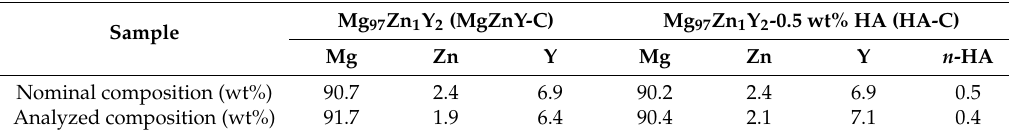
Table 5. Nominal and analyzed compositions of the